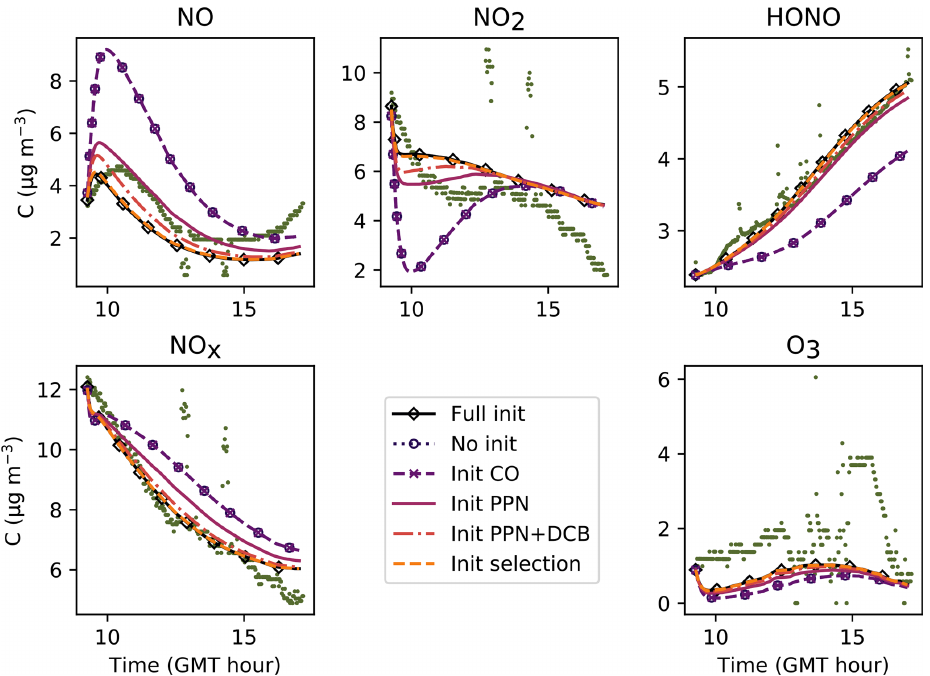
Figure 6. Inorganic concentration profiles for different initial conditions. The dots denote the experimental measurements (Experiment 3). “No init” means that all the compounds which were not detected during the campaign are a given a zero concentration at the start of the simulation. “Full init” means that all the compounds are initialized, even those which were not experimentally detected (see text for details). “Init CO” is like “No init” but with CO initialized. “Init PPN” is like “No init” but with PPN initialized . “Init PPN+DCB” is like “No init” but with PPN, DCB1, DCB2 and DCB3 initialized. “Init selection” is like “No init” but with PPN, DCB1, DCB2, DCB3, MGLY and PAN initialized. The curves corresponding to “Full init” and “Init selection” are close to being